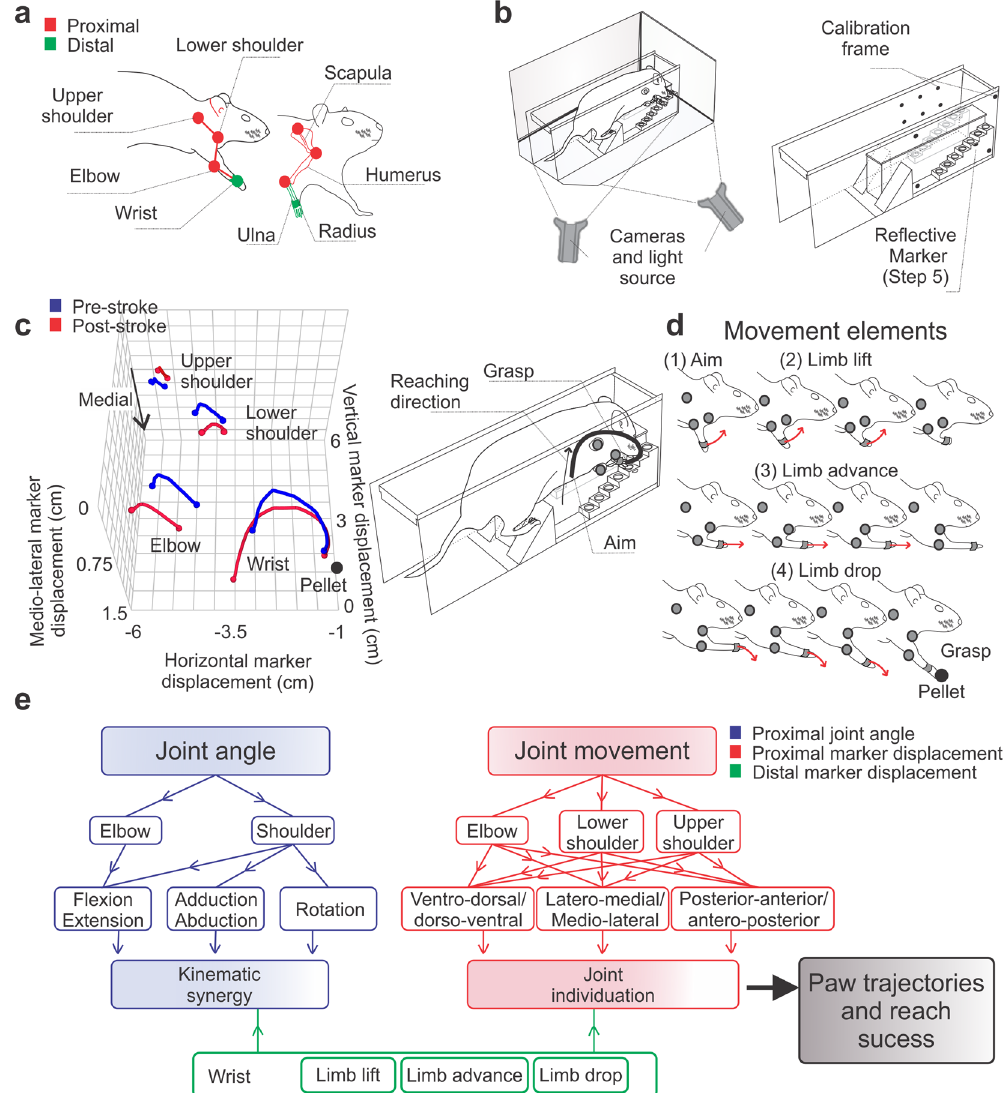
Figure 2. Proximal and distal upper limb movements measured using kinematic analysis. ( a ) Location of reflective markers (red: proximal segments; green: distal segments). (b) Two synchronized video cameras were used to determine the coordinates of upper limb movements. A calibration frame and a reference marker (step 5) were used to calibrate and normalize the kinematic data. (c, left panel) Reconstruction showing the mean reaching trajectories in the staircase (blue: pre-stroke, red: post-stroke). The black trace (c, right panel) shows the wrist movement during post-stroke reaching. ( d ) Reaching was divided into four movement elements 23,37 : (1) aim; a static position of the limb used to aim the paw before the beginning of the reaching movement, (2) limb lift; the upward paw movement that precedes limb advance, (3) limb advance; the forward movement of the paw towards the pellet, and (4) limb drop; the downward movement of the paw to reach for the pellet. ( e ) Summary of terminology and components of synergy analysis used throughout the manuscript. Proximal elbow (flexion/extension) and shoulder joint (flexion/extension, adduction/abduction and internal/external rotation) angles (blue) or movements (red) were compared to distal wrist movements (green) to compute kinematic synergy and joint individuation. When attempting a voluntary reaching movement, the proximal upper limb segments (elbow and shoulder) work in coordination to stabilize wrist trajectory and to facilitate reaching and grasping. Abnormalities in kinematic synergies and joint individuation have been associated with muscle spasticity (kinematic synergy) 5,31,32 and impairments in coordination (joint individuation) 11,38 possibly leading to unstable wrist trajectories and reduced reach success (black arrow and